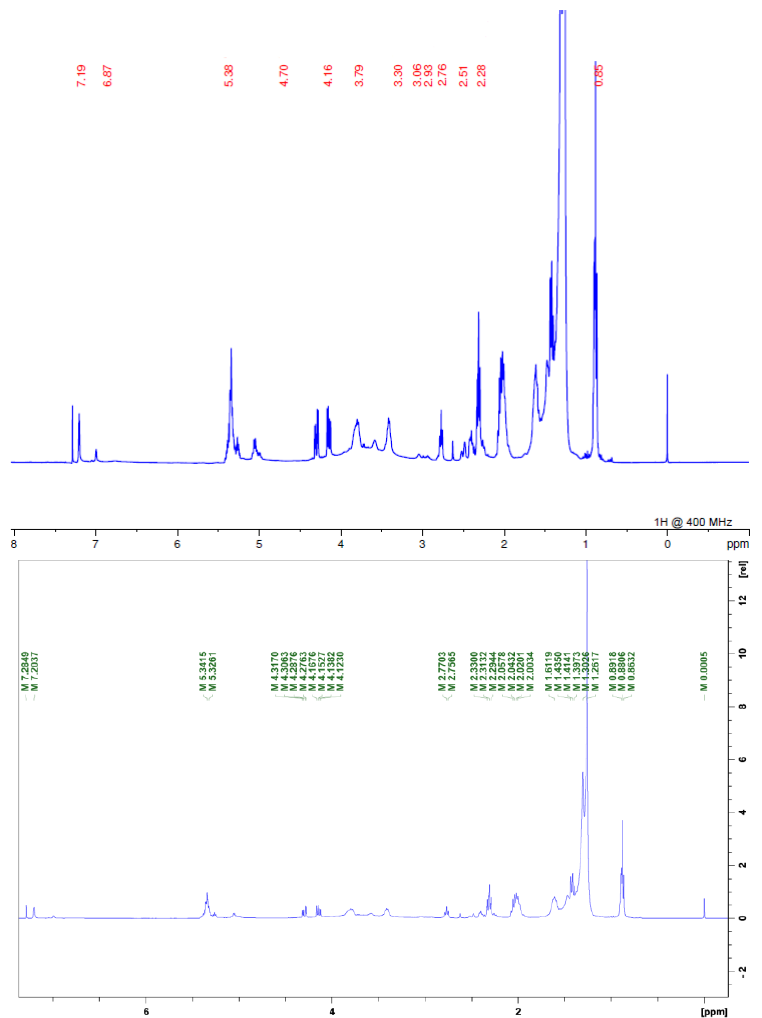
Figure 3. EESAM 1 H NMR spectrum. Source: Authors.